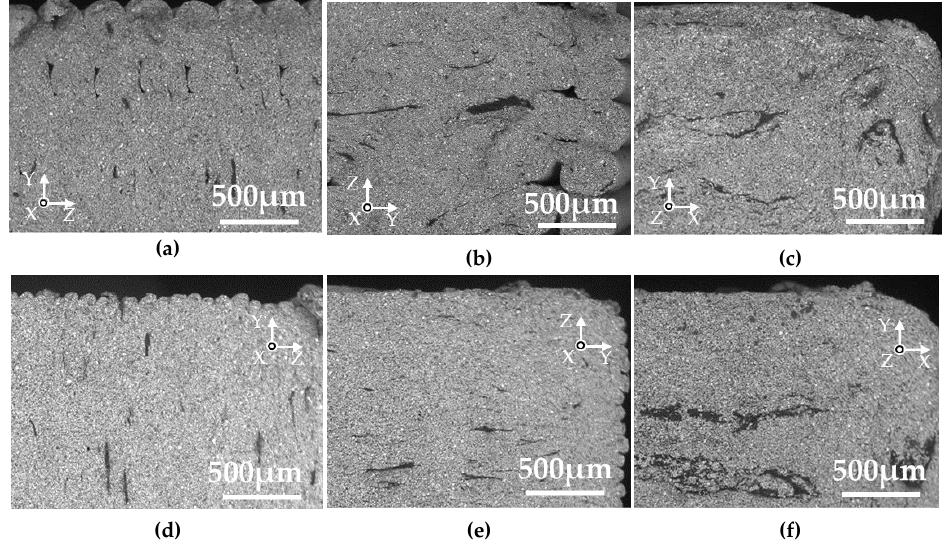
Figure 8. SEM micrographs of cross-sections perpendicular to the length direction of the green parts. ( a ) W-specimen, thickness 0.3 mm; ( b ) T-specimen, thickness 0.3 mm; ( c ) L-specimen, thickness 0.3 mm; ( d ) W-specimen, thickness 0.1 mm; ( e ) T-specimen, thickness 0.1 mm; ( f ) L-specimen, thickness 0.1